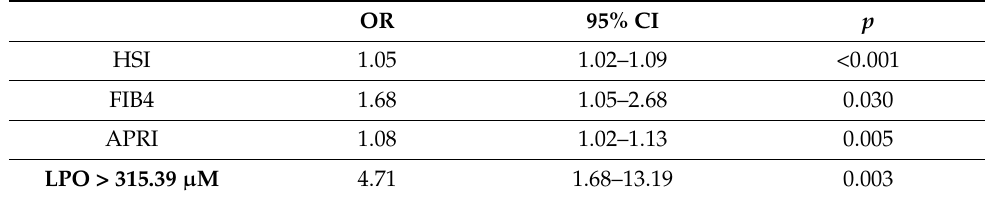
Table 3. Automatic multivariate logistic regression analysis to evaluate the independent association of LPO levels and risk of a NASH score of ≥